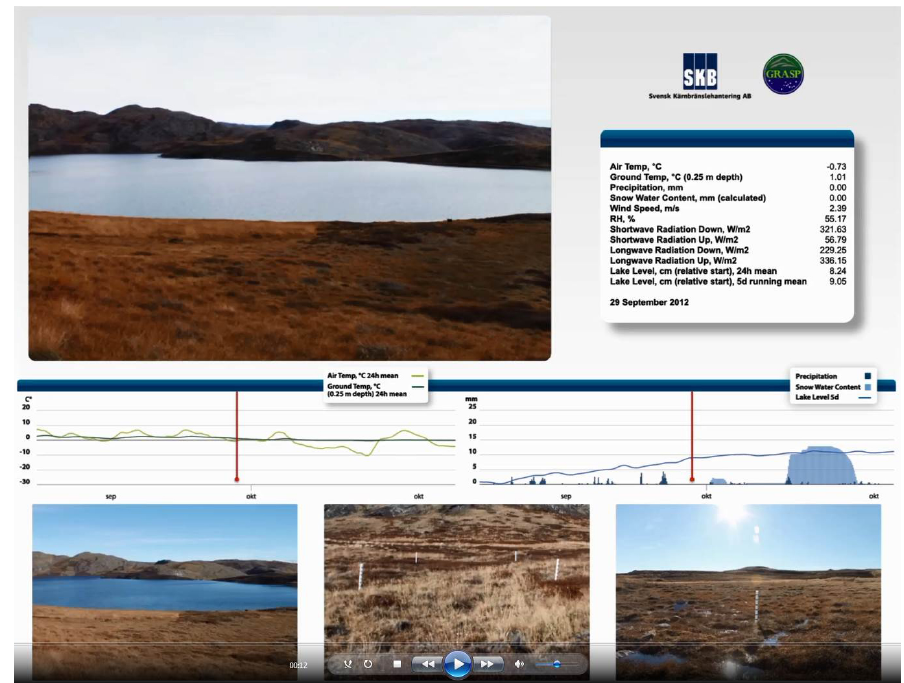
Figure 9. The user interface of the time-lapse